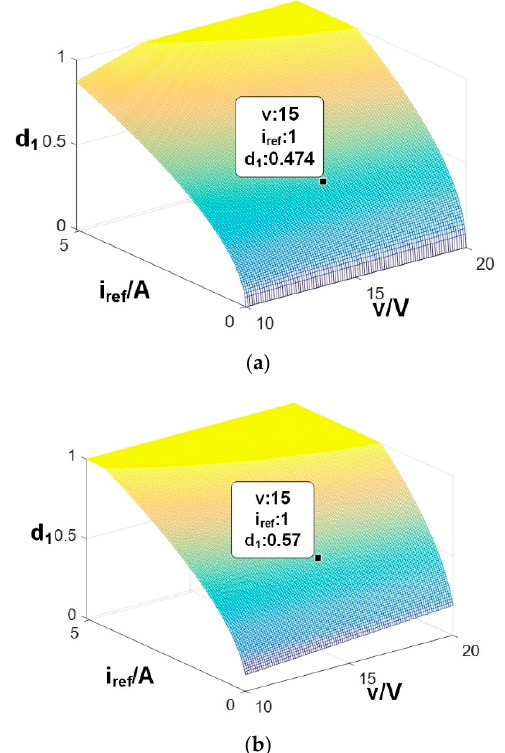
Figure 11. Duty cycle calculated by different current controllers. ( a ) ACC, ( b ) DACC. The DACO calculates a lower output current average value than that of ACO. Taking operation = = as an example, the output currents are 1.1 A and 0.77 A, respectively. point 1 { 0.5, 15V} d v Therefore, a current damp of 0.7 OM k = exists between the results. The DACC calculates a higher duty cycle than that of ACC. Taking operation point { 15V, 1A} ref v i = = as an example, the calculated duty cycles are 0.474 and 0.57, respectively.